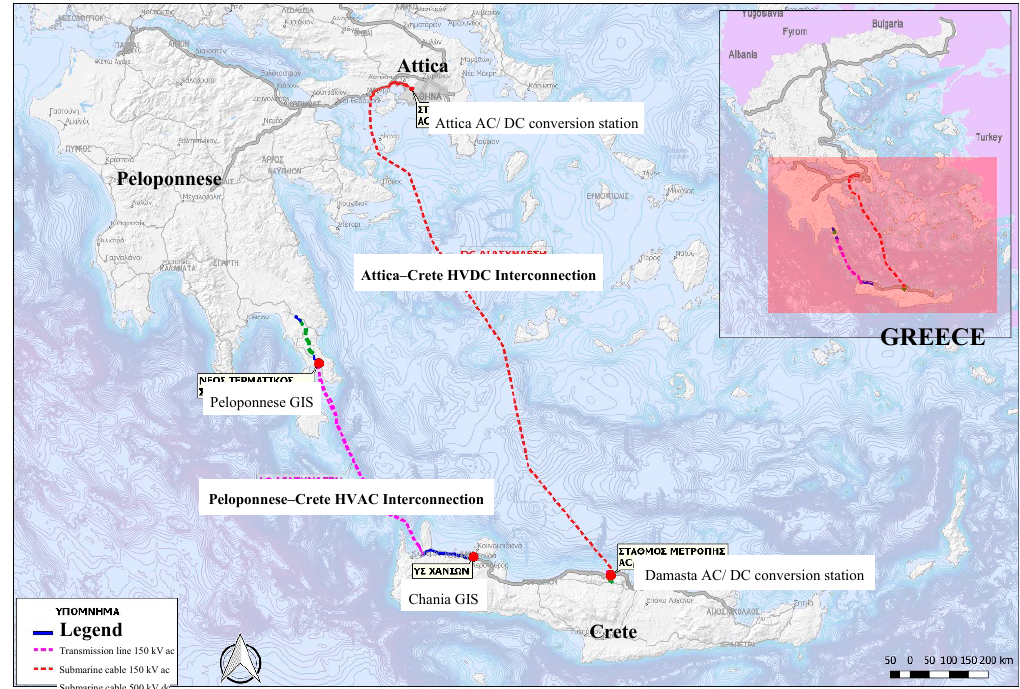
Figure 1. Geographical map of interconnections between Crete and the continental Greece power